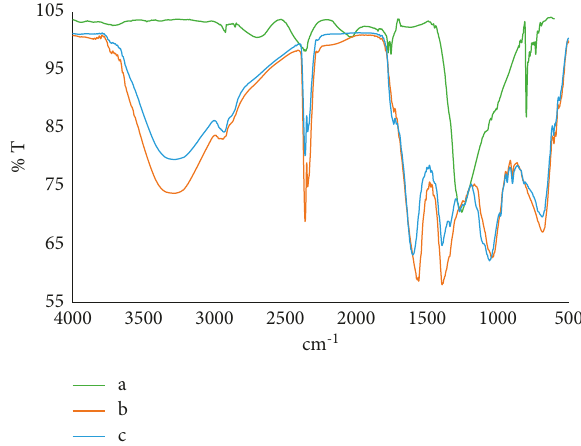
Figure 3: FTIR spectra of silver nitrate (a), A. arborescens extract (b), and silver nanoparticles- A. arborescens extract (c).